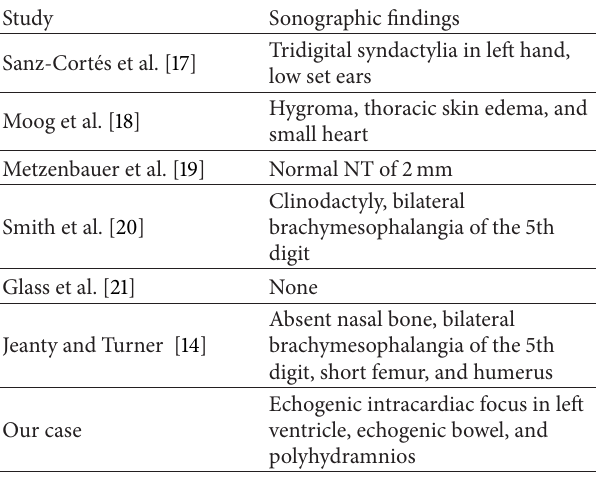
Table 1: Prenatally diagnosed cases of 48